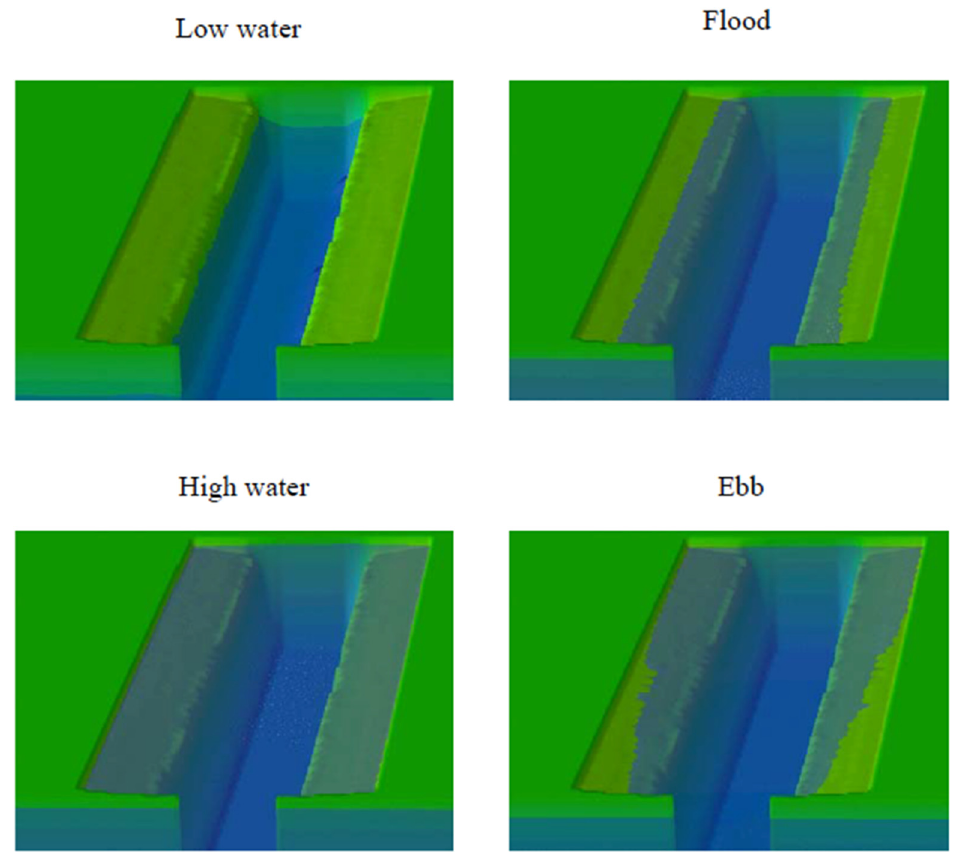
Figure 5. A 3-D view of the flooding/drying process over an M 2 tidal cycle. Selecting sites A (at the channel center), B (at the edge of the main channel and intertidal zone), and C (within the intertidal zone), we examined the changes in water elevation ( ζ ), along-channel current ( U ), and cross-channel current ( V ) over tidal cycles (Figure 6). The water elevation at sites A and B were almost identical. They changed stably with an M2 tidal period after a two-tidal cycle spin-up. At site A, the along-channel current was predominant, changing nearly symmetrically over the flood and ebb-tidal periods. At site B, although the water elevation varied symmetrically over the flood and ebb-tidal periods, the currents over the ebb-tidal period varied slowly and lasted much longer. Site C became wet during the flood-tidal period. At that site, the water elevation reached its maximum synchronously with the water change within the channel. The water was drained rapidly during the ebb-tidal period. The change in the cross-channel velocity varied with M 2 tidal cycles due to temporospatial variation of vertical viscosity and horizontal diffusion. This result suggests that if I split is appropriately selected, FVCOM can simulate the flooding/drying process with sufficient accuracy that mass conservation errors are insig- nificant. Clearly, by this criterion, the upper bound for I split exceeds 6 for the standard case conditions. Next, we consider how the upper bound of I split depends on the other parame- ter values.